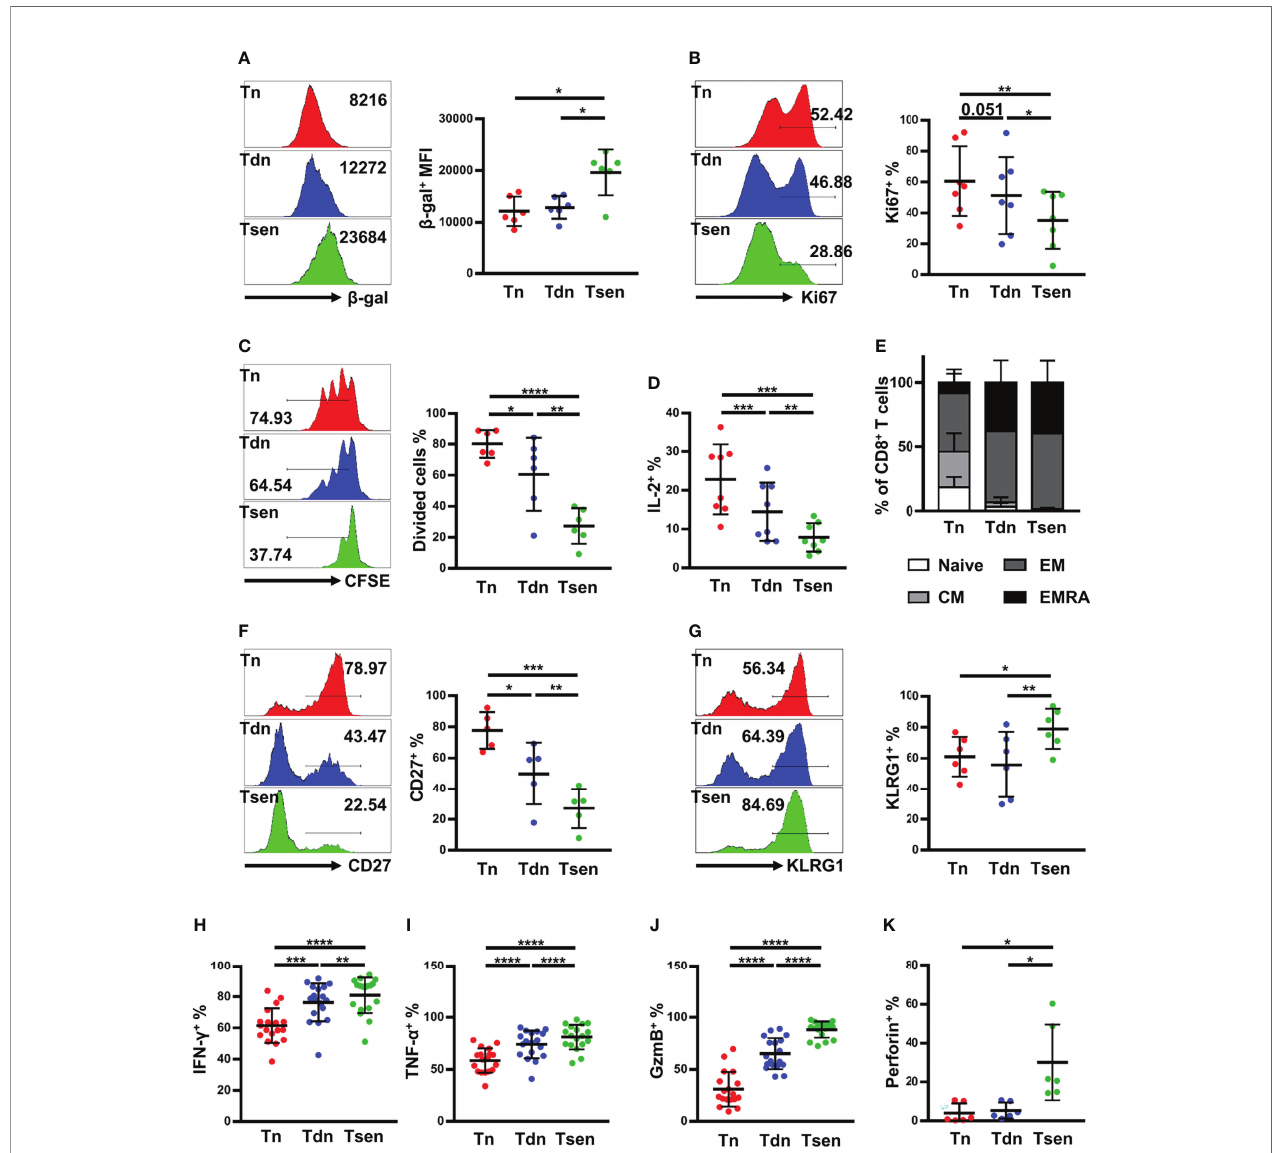
FIGURE 4 | Ascitic Tsen CD8 + T cell in patients with HGSOC have a distinct senescent phenotype. The representative fl ow cytometry plots and the statistic diagram show (A) the mean fl uorescence intensities (MFI) of SA- b -gal (n = 6); (B) the percentage of Ki-67 + (n = 7); (C) the level of dividing cells (n = 6); and (D) the percentage of IL-2 + (n = 8) in Tn, Tdn, and Tsen CD8 + T cells. (E) The statistic diagram shows the frequency of naive, CM, EM, and TEMRA (de fi ned using the markers CCR7 and CD45RA) within Tn, Tdn, and Tsen CD8 + T cells (n = 22). The representative fl ow cytometry contour plots and the statistic diagram show the percentage of T-cell differentiation-associated markers (F) CD27 + (n = 5) and (G) KLRG1 + (n = 6) on Tn, Tdn, and Tsen CD8 + T cells. The representative fl ow cytometry plots and the statistic diagram show (H) IFN- g (n = 18), (I) TNF- a (n = 18), (J) granzyme B (n = 18), and (K) perforin (n = 6) expression by Tn, Tdn and Tsen CD8 + T cells on stimulation with PMA/ionomycin for 6 h. Groups were compared using paired t-test (A, C, D, F, G, I) or Mann – Whitney U-test (B, H, J, K) . Bars show mean with SD.*, P < 0.05; **, P < 0.01; ***, P < 0.001; ****, P <